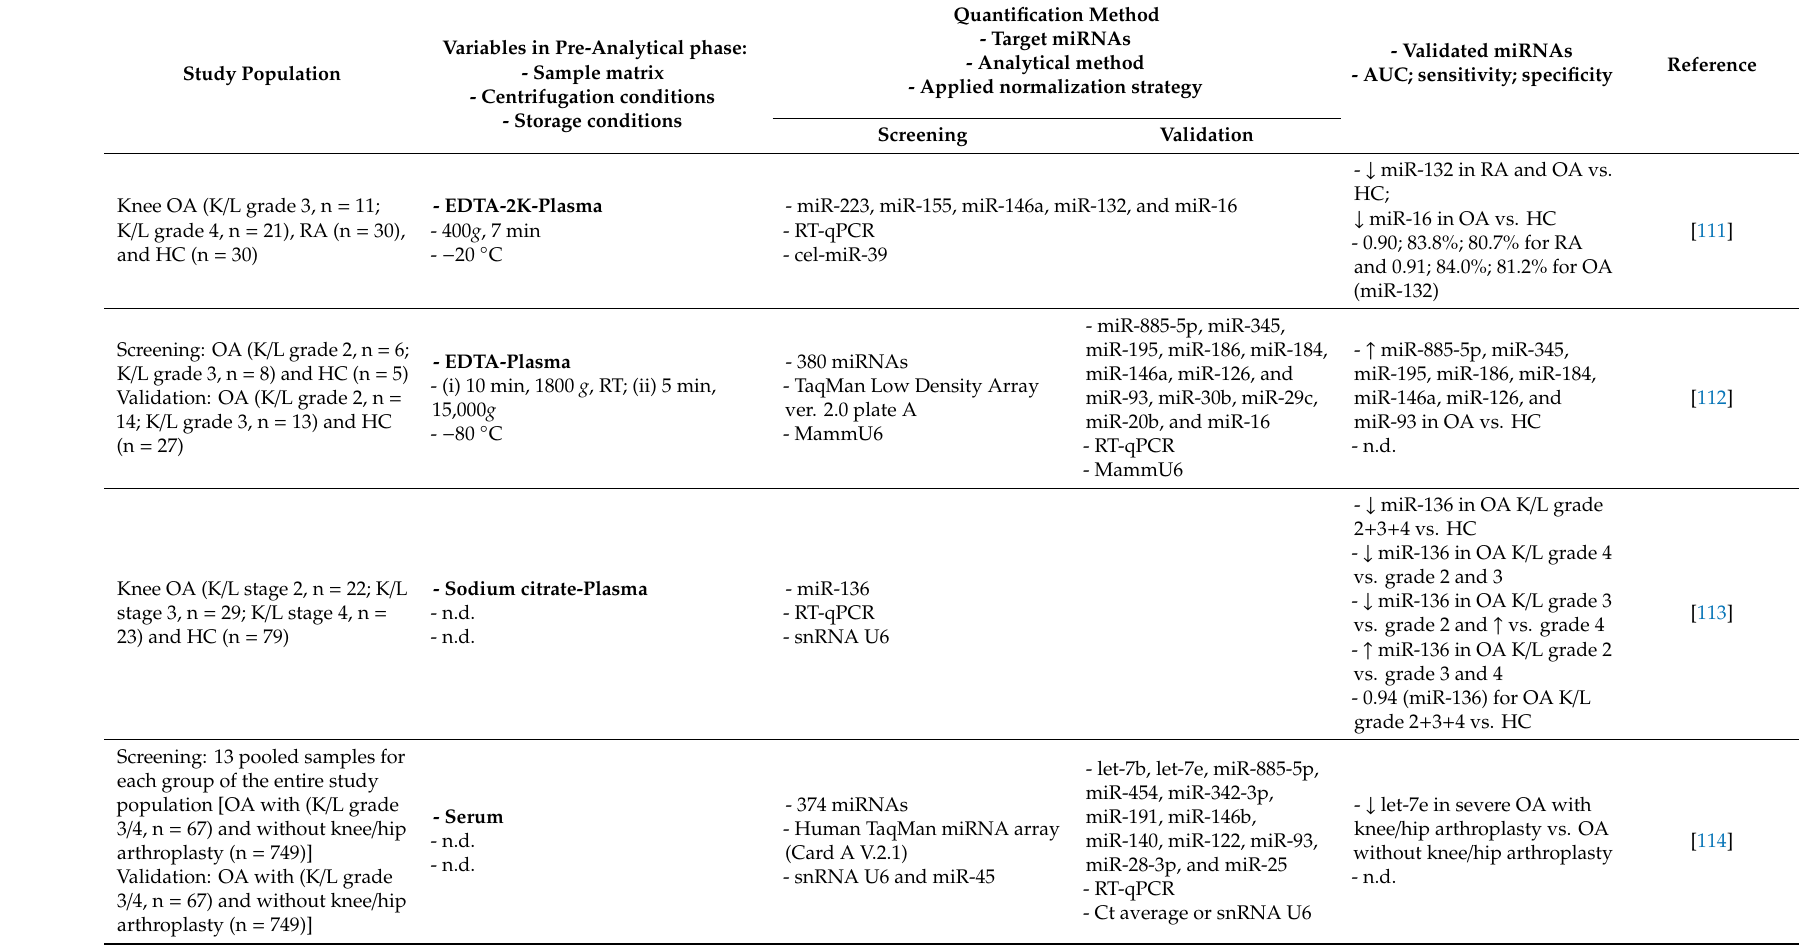
Table 3. Circulating miRNAs related to osteoarthritis